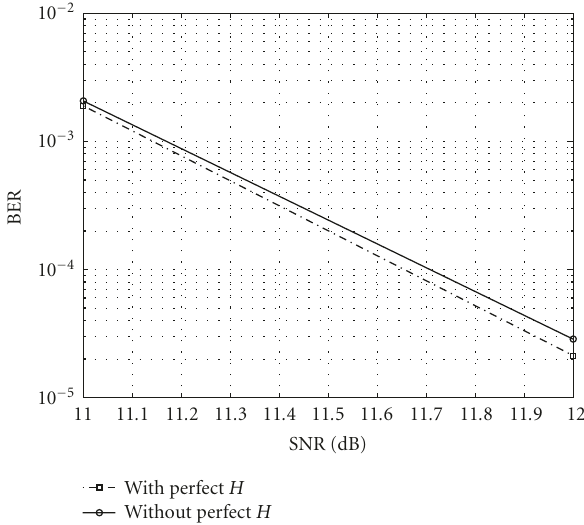
Figure 6: BER of the (175,255) LDPC code. The dash-dot line is the BER curve with perfect channel knowledge and the solid line is the BER curve without perfect channel